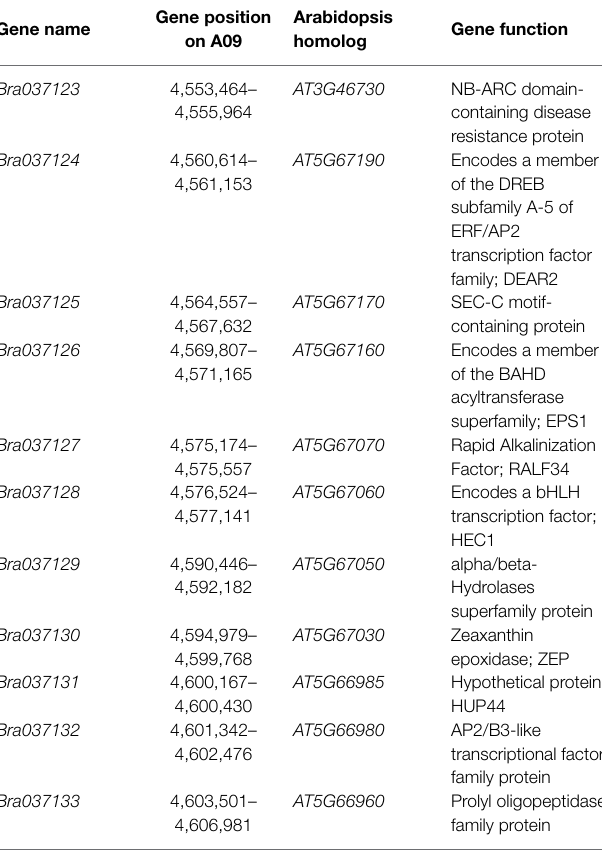
TABLE 2 | Annotated genes in the candidate interval of the Br-dyp1